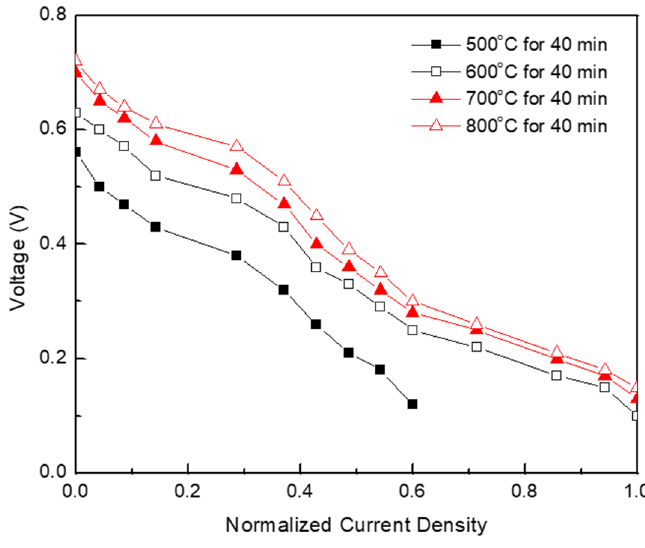
Figure 4. E ff ect of KOH-treatment of the carbon porous electrode (CPE) on the cell performance. The treatment was conducted by submerging CPE in KOH solution overnight and then thermally treating it in an argon environment.